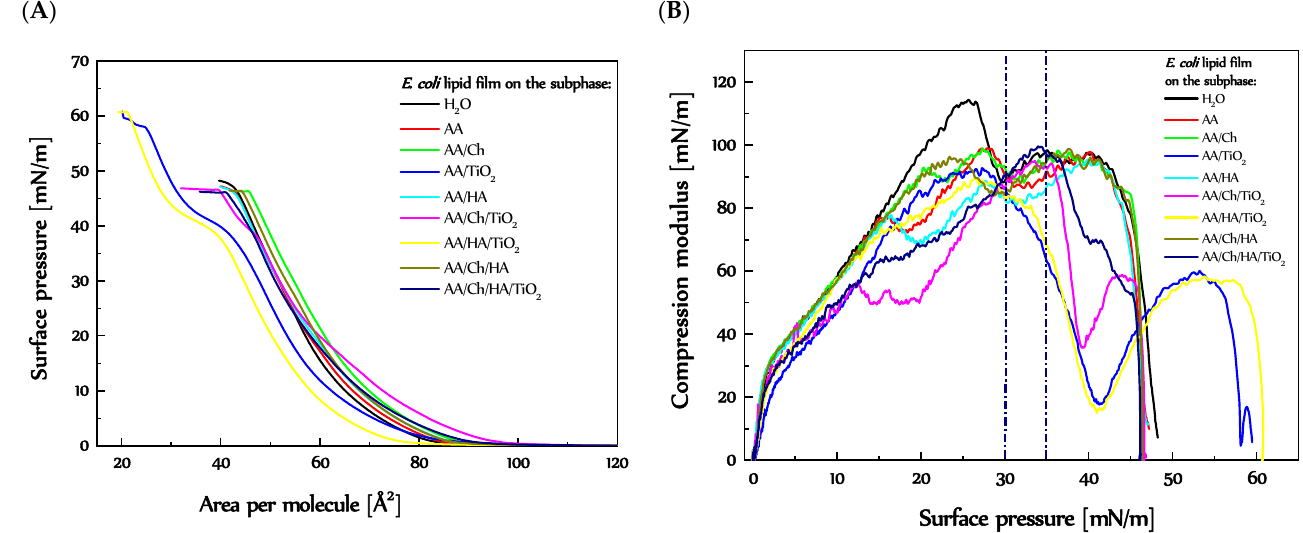
Figure 7. ( A ) π -A isotherms obtained by means of the Langmuir technique and determined based on them ( B ) C S − 1 = f( π ) relationship for E. coli lipid monolayers on the individual subphases (more details Figure S5).